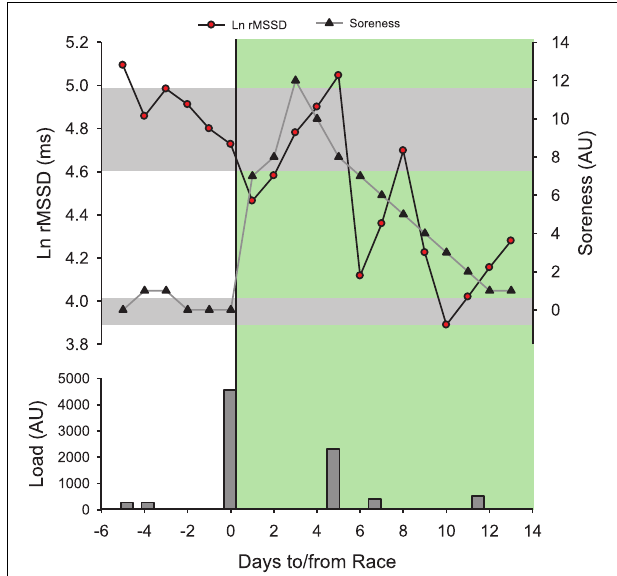
FIGURE 9 | Time course of the logarithm of the square root of the mean of the sum of the squares of differences between adjacent normal R-R intervals measured supine at rest in the morning (Ln rMSSD) and perceived muscle soreness (Soreness, 0–10 scale) in a distance runner (32 year-old, VO 2max = 59ml/min/kg, vVO 2max = 18km/h) before and after his first mountain trail (53km, 4400m of positive ascent in 8h 22min). Training/competitive load was provided as perceived exertion (CR-10 Borg scale) × training/race duration (Impellizzeri et al., 2004). All sessions were run-based except the one at post-race + 5 days which was a bike session. The green area represents the post-race recovery period. Gray areas represent trivial changes for both Ln RMSSD and Soreness. Note that post-race Ln rMSSD recovers within 2 days and rebounds above pre-race levels within 5 days. The recovery time course of Ln rMSSD unexpectedly mirrors the dramatic increase in post-race Soreness. The impressive increase in Soreness (12/10 scale!) is likely related to the fact that the runner was only used to run on flat courses (i.e., marathon training, Figure 5 ) and not specially prepared for mountain running at that time. The post-race changes in HRV follow initially the expected hemostasis recovery (rebound), and then likely reflect a detraining state after the first week of